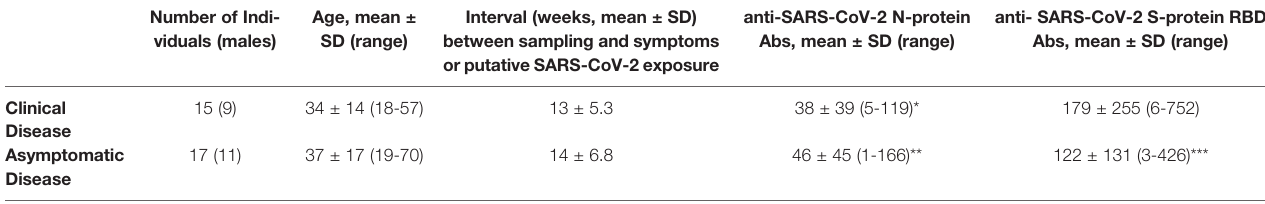
anti-SARS-CoV-2 N-protein Abs, mean ± SD